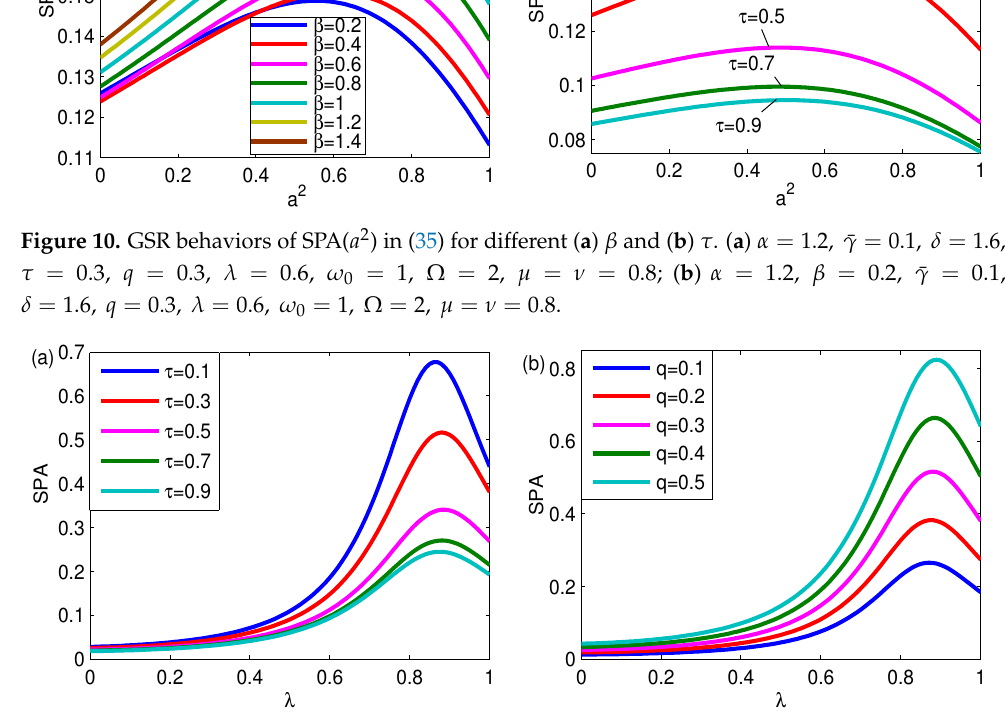
Figure 11. GSR behaviors of SPA( λ ) in (35) for distinct ( a ) τ and ( b ) q . ( a ) α = 1.2, β = 0.2, ¯ γ = 0.1, δ = 1.6, a 2 = 0.6, q = 0.3, ω 0 = 1, Ω = 2, µ = ν = 0.8; ( b ) α = 1.2, β = 0.2, ¯ γ = 0.1, δ = 1.6, τ = 0.3, a 2 = 0.6, ω 0 = 1, Ω = 2, µ = ν =